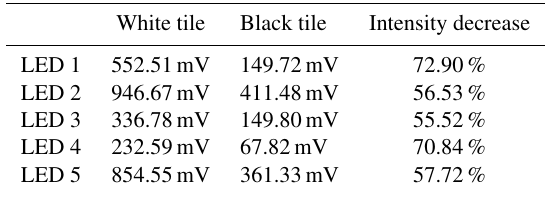
Figure 8. Sensor output at different distances from 5 to 15cm in 1cm step with the black tile surface without water. Table 2. Experimental results for significant parameters of the man- ufactured